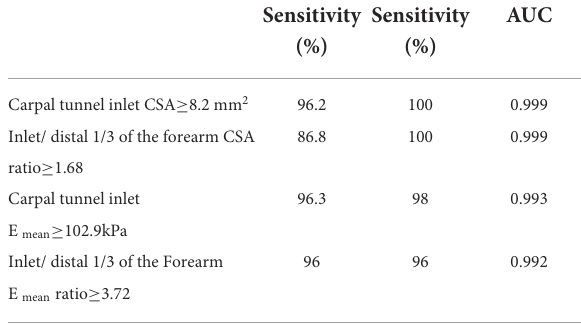
TABLE 5 AUC, sensitivity, specificity, and optimal cut-off values of nerve parameters for the diagnosis of